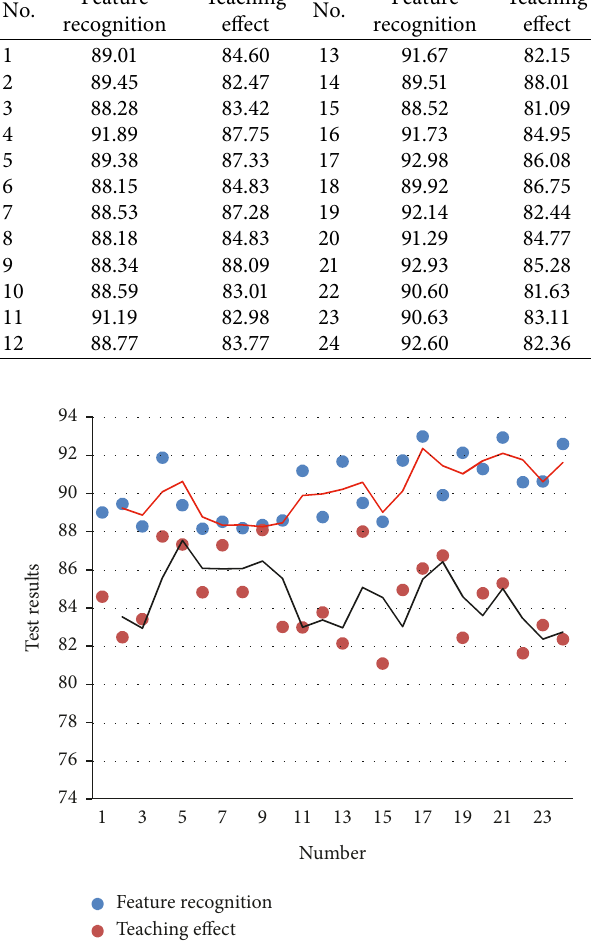
Figure 12: Statistical diagram of simulation test